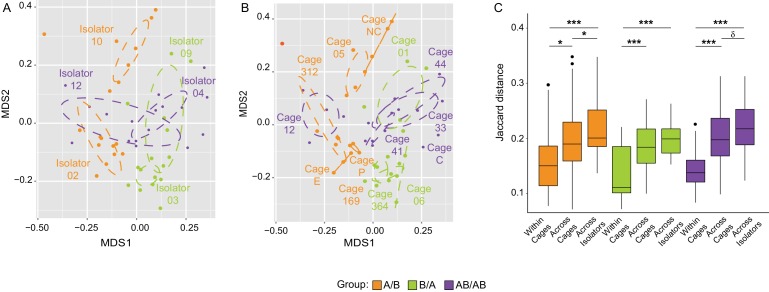
Impact of dispersal limitation on gut microbiome composition.NMDS plot (Jaccard dissimilarity) with samples color-coded by treatment and grouped by the isolators (a) or cages (b) they were housed in. (c) Boxplots of Jaccard distances of the microbiota profile of mice housed within the same cage, across cages within an isolator, and across isolators; ANOVA tests were done within treatments to exclude the effect of colonization order. ***p<0.001, **p<0.01, *p<0.05, δp<0.1.